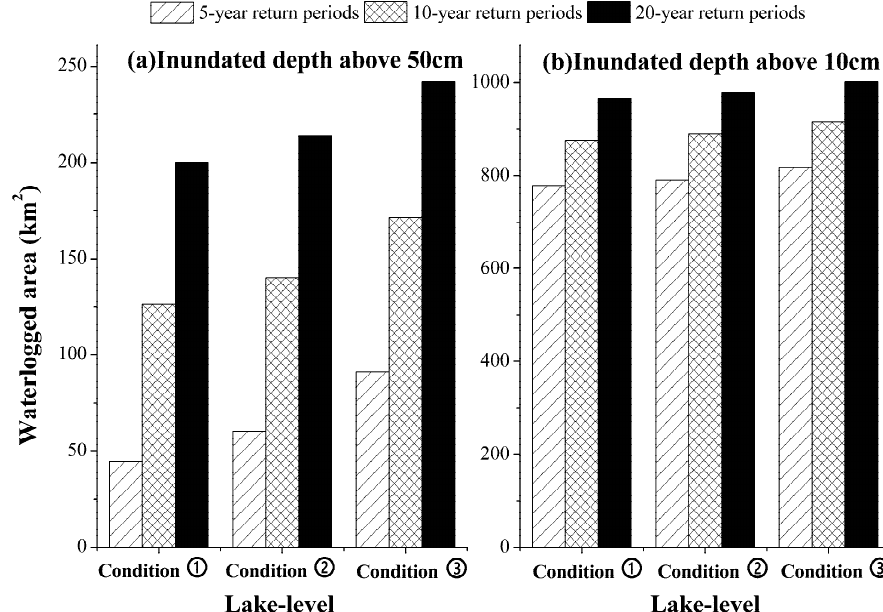
Figure 5. The changes in the area of inundation in the lakeside area according to the changes in the lake level.